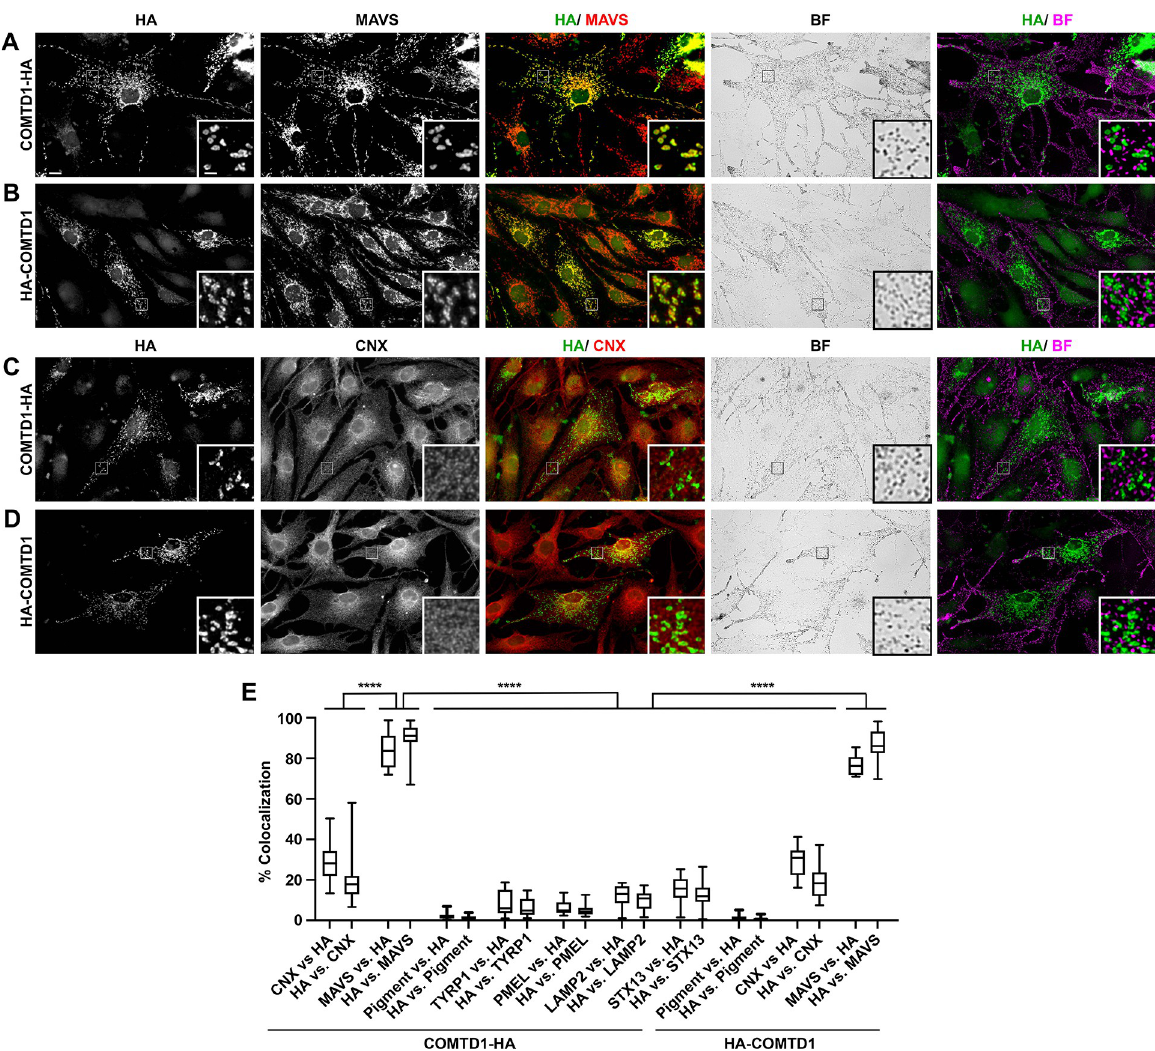
Fig 5. HA-tagged COMTD1 localizes to mitochondria in immortalized mouse melanocytes. (A-D) Immortalized melan-Ink4a cells from Ink4a-deficient C57BL/6J mice were transiently transfected to express COMTD1 fused with the HA11 epitope at either the N-terminus (HA-COMTD1; A, C) or C-terminus (COMTD1-HA; B, D). Two days later, cells were fixed and analyzed by bright field (BF) and immunofluorescence microscopy for HA and either the mitochondrial resident protein MAVS (A, B) or the ER resident protein calnexin (CNX; C, D). Individual images of labelled cells or the bright field image are shown in addition to an overlay of HA (green) with MAVS (red; HA/ MAVS), CNX (red; HA/ CNX), or the pseudocolored bright field image (magenta; HA/BF). Insets show a 5-fold magnified image of the boxed region to emphasize overlap or lack thereof. Main scale bar, 10 μ m; inset scale bar, 2 μ m. (E) Quantification of the degree of overlap of COMTD1-HA or HA-COMTD1, as indicated, with markers of the ER (CNX; N = 29 for COMTD1-HA, N = 17 for HA-COMTD1), mitochondria (MAVS; N = 25 for COMTD1-HA, N = 16 for HA-COMTD1), mature melanosomes (TYRP1; N = 16), immature melanosomes (PMEL; N = 17), late endosomes/ lysosomes (LAMP2; N = 15), or early endosomes (STX13; N = 21). Data from 4–5 individual experiments are presented as a box and whiskers plot in which the area of overlap is shown relative to the total area occupied by HA (e.g., CNX vs. HA) or by the indicated marker (e.g., HA vs. CNX). See S2 Fig for examples of the data for TYRP1, PMEL, LAMP2 and STX13. Statistical significance was determined by ordinary one-way ANOVA with Tukey’s tests for multiple comparisons; **** , P <